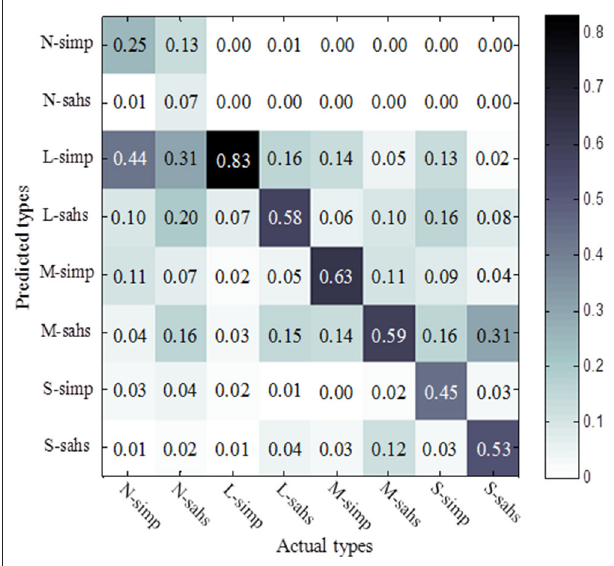
FIGURE 6 | Confusion matrix of eight types.